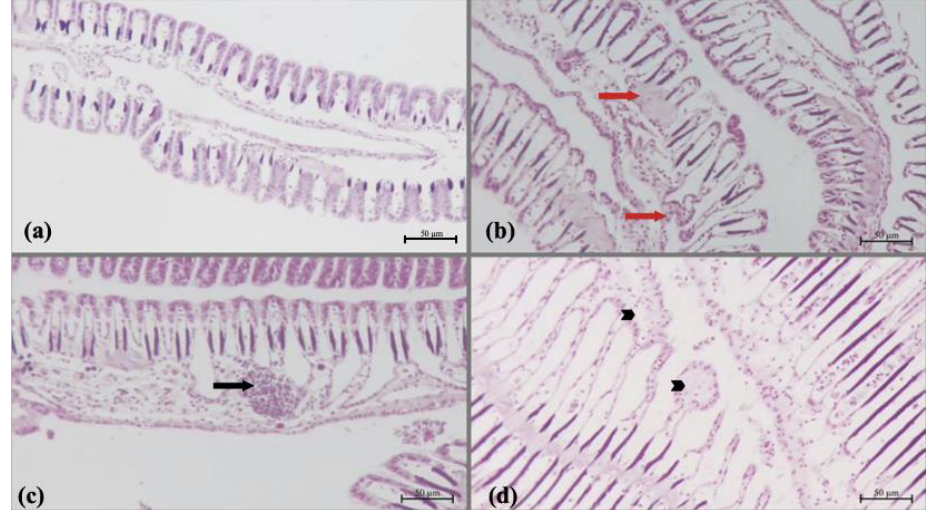
Figure 6. Gill tissue of freshwater mussel, the Unio delicatus ( a ) control, ( b ) lamellar deformation of the gills (red arrows) after exposure to 0.528 mg/L fipronil for 48-h, ( c ) haemocytic infiltration (black arrows) after exposure to 0.264 mg/L fipronil for 7-d, ( d ) epithelial hyperplasia of the lamella after exposure to 0.524 mg/L fipronil for 7-d (black arrow heads)